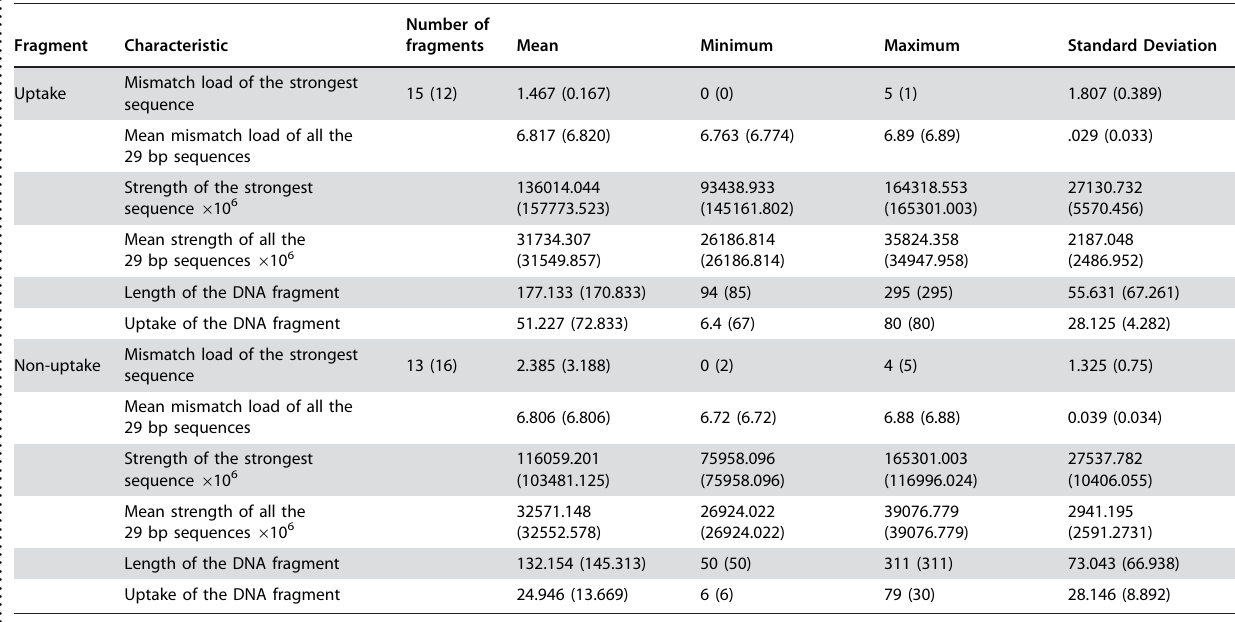
Table 2. Characteristics of the DNA fragments tested for uptake in [40]. .. ... .... ... ... .... ... ... .... ... ... .... ... ... .... ... ... .... ... ... .... ... ... .... ... ... .... ... ... .... ... ... .... ... ... .... ... ... .... ... ... .... ... ... .